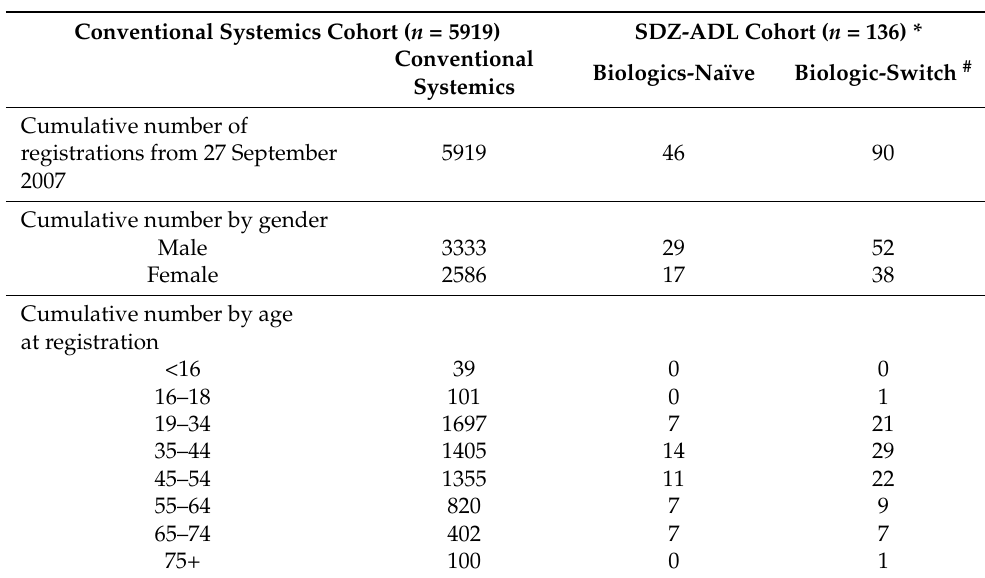
Table 1. Baseline demographic characteristics of patients registered in the conventional and SDZ-ADL cohort from the safety set.